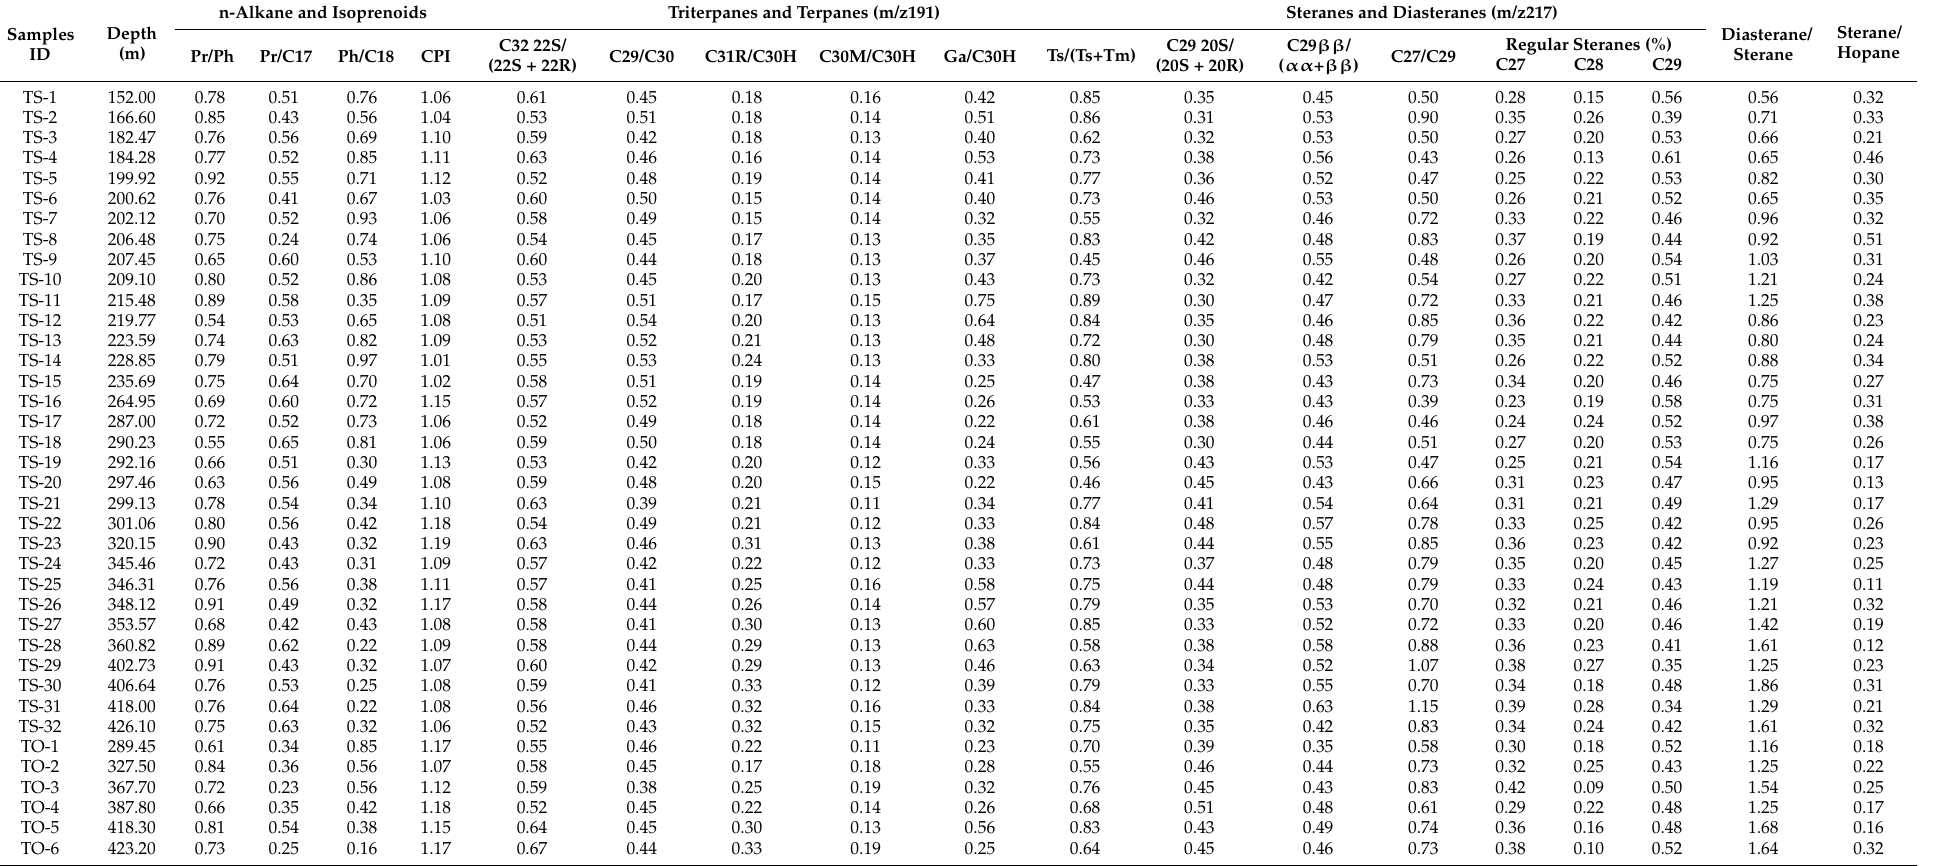
Table 4. n-alkane and isoprenoid biomarker